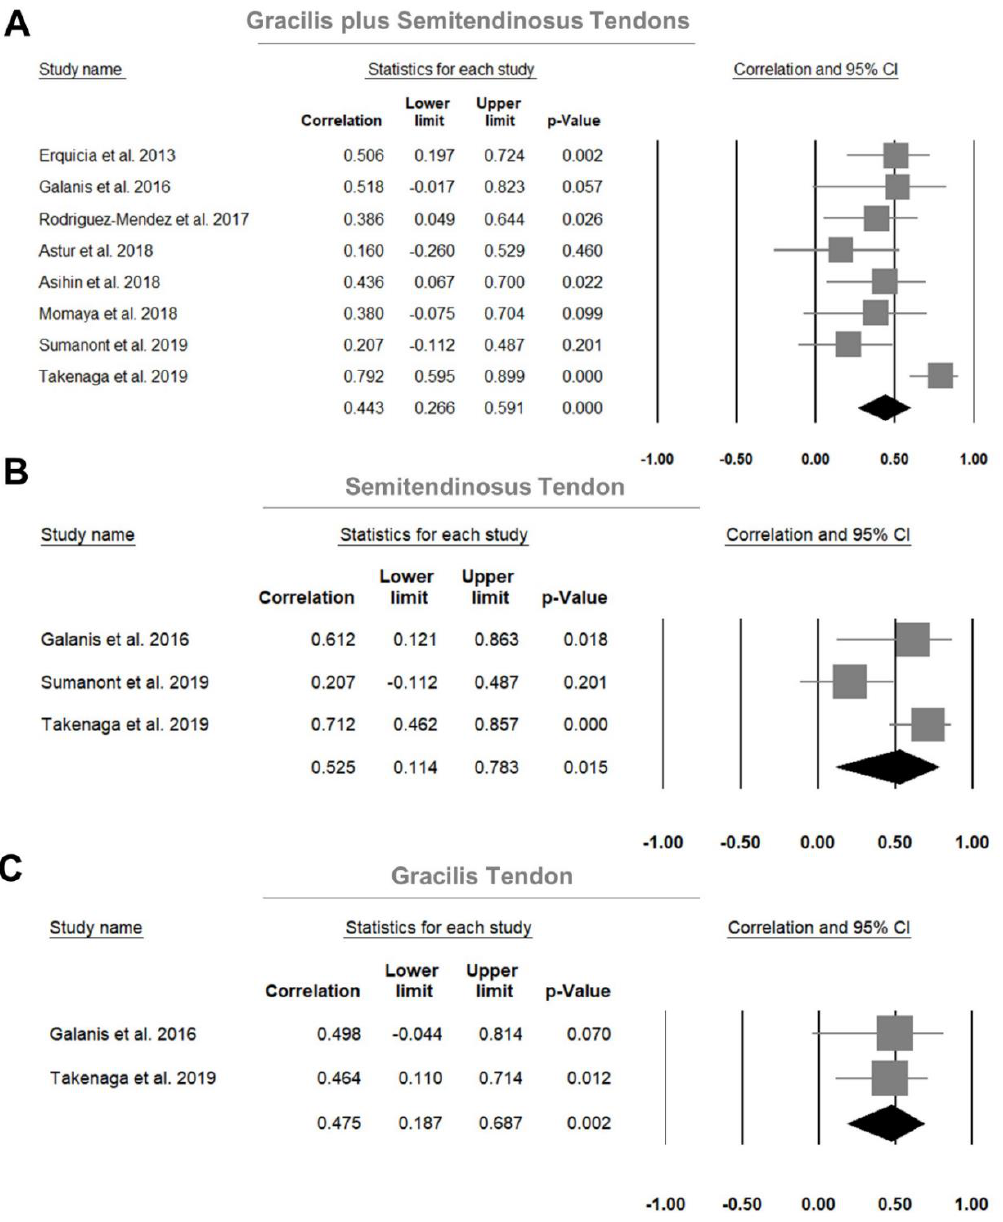
Figure 2. Forest plots of the summarized correlations between the ultrasound measurements and the intra-operative autograft diameter for ( A ) the gracilis plus semitendinosus tendons, ( B ) the semitendinosus tendon and ( C ) the gracilis tendon. CI, confidential interval.